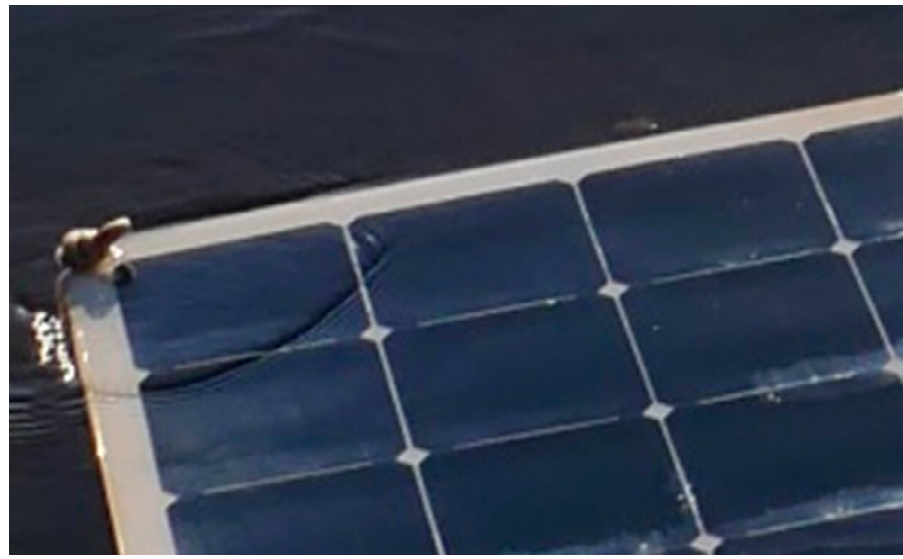
Figure 2. Closeup of floating photovoltaic/floatovoltaic (FPV) corner after deployment, showing water coverage from a modest wave (top left).